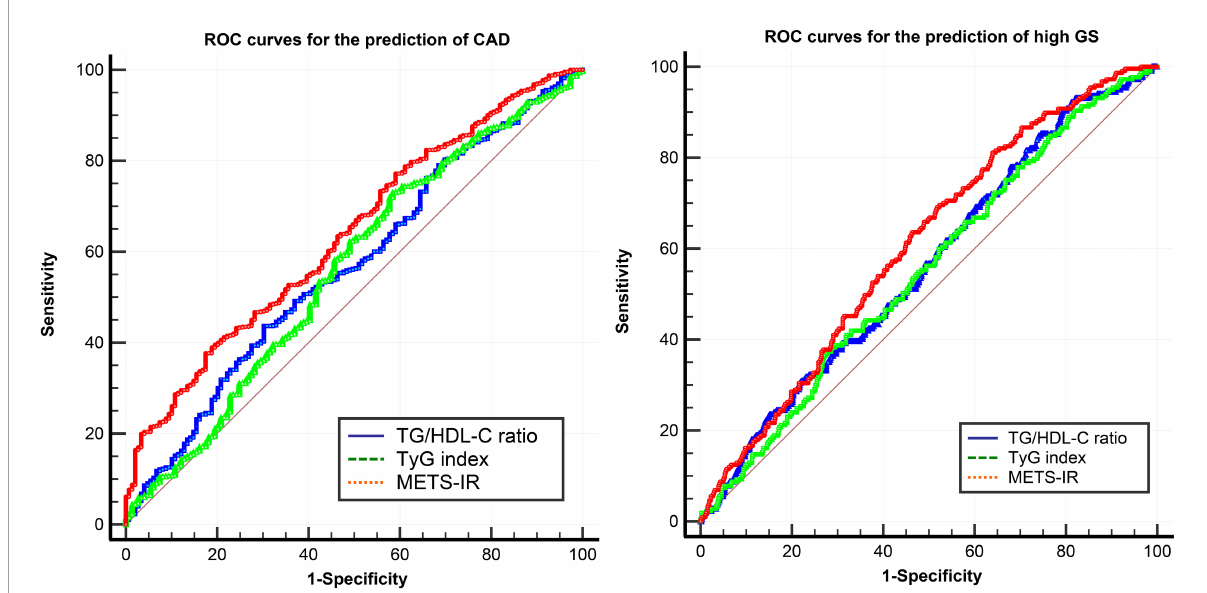
FIGURE4 ROC curves of the TG/HDL-C ratio, TyG index, and METS-IR for the prediction of CAD and high GS. ROC curves, receiver operator characteristic curves; CAD, coronary heart disease; GS, Gensini score; TG/HDL-C ratio, the ratio of triglycerides to high-density lipoprotein cholesterol; TyG index, triglyceride and glucose index; METS-IR, metabolic score for insulin resistance.